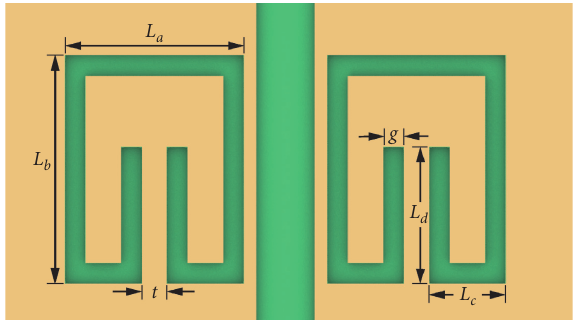
Figure 5: The coupling structure between the slot antenna and CCLL.